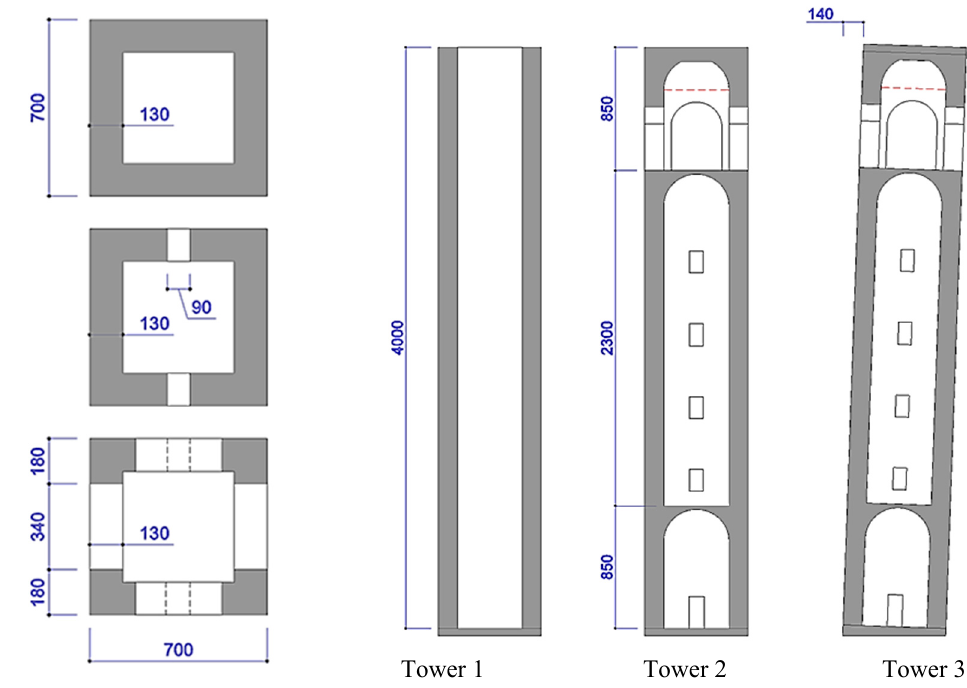
Figure 4. Cross-sections and section views of the towers.